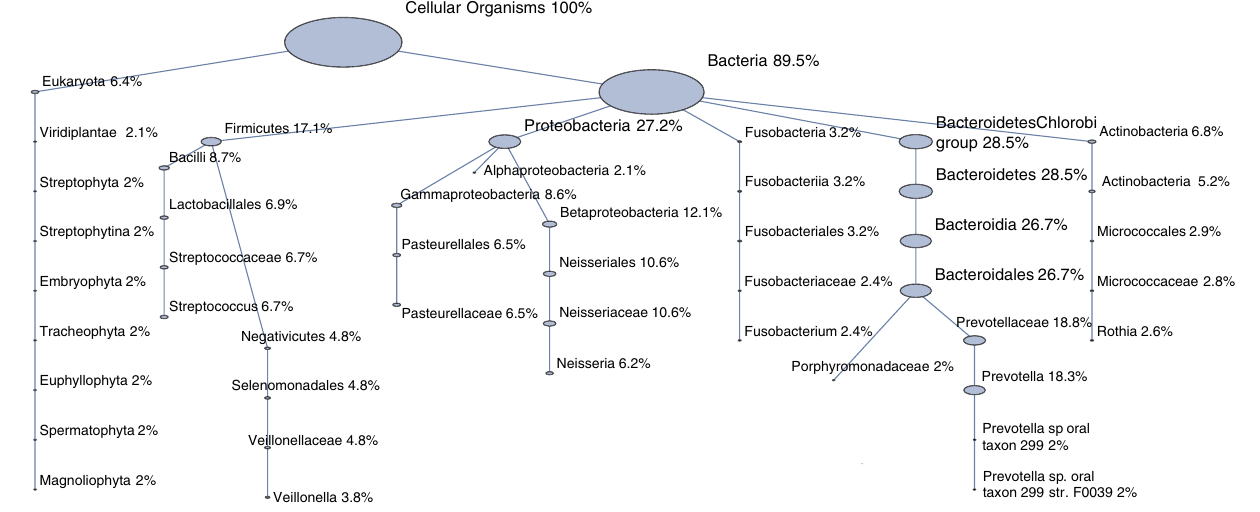
Top Taxa Nodes: Specific Normalised Read Count